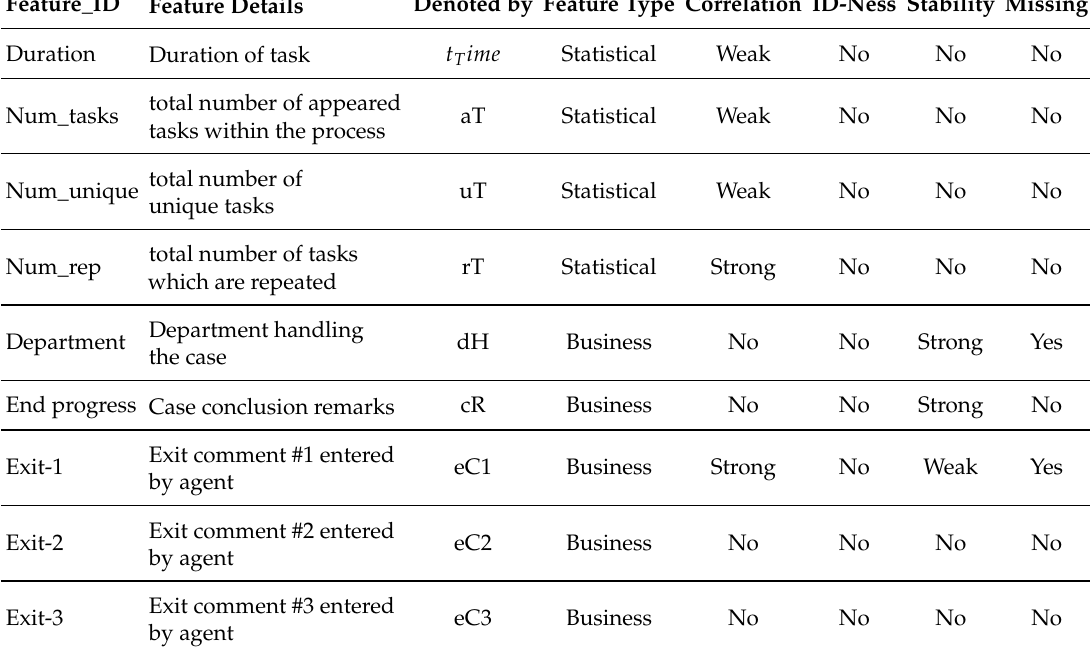
Table 3. Initial feature set before the selection of discriminating